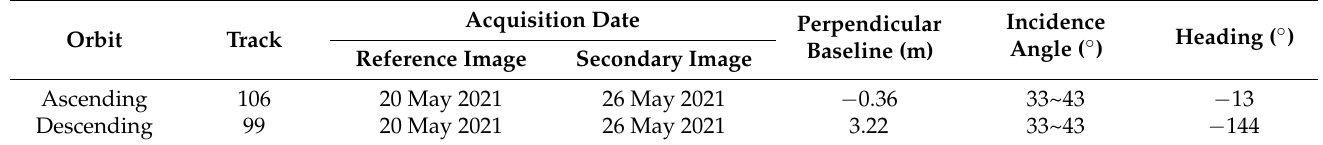
Table 1. Parameters of the Sentinel-1A SAR images used in this